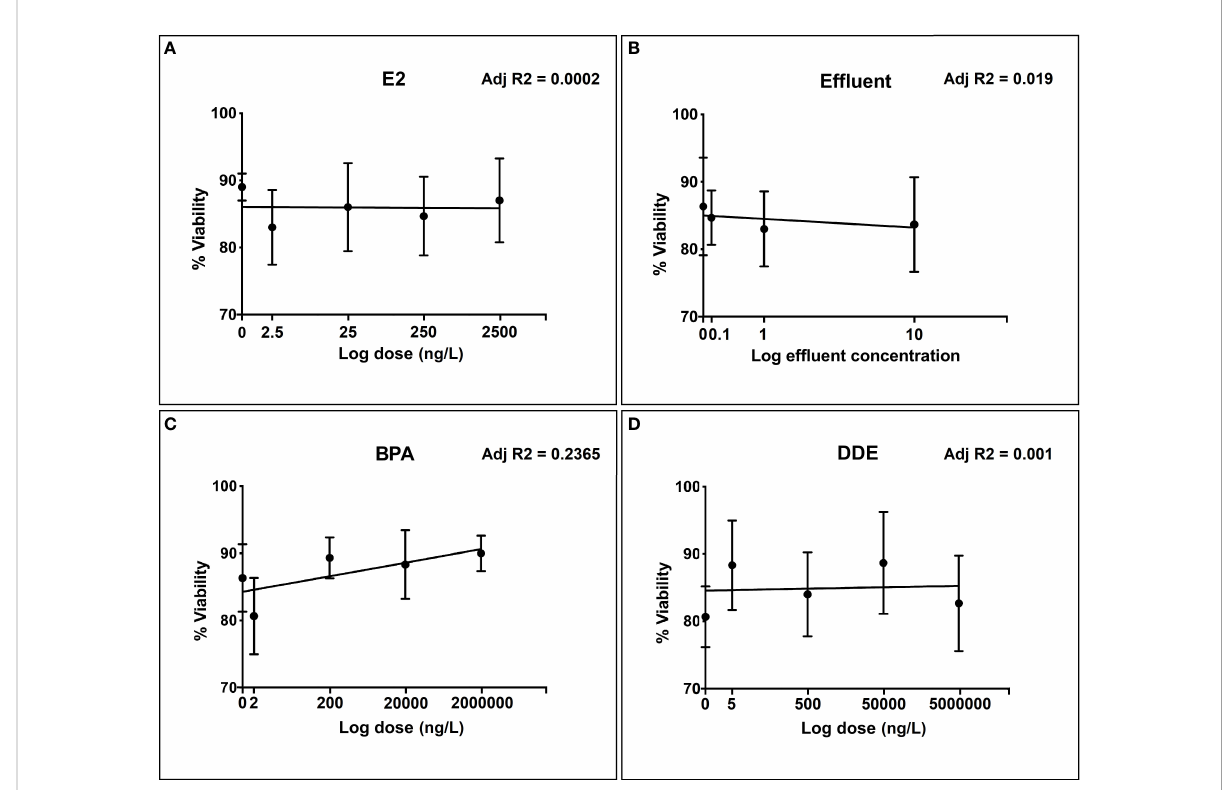
FIGURE 1 Toxicity evaluation of different doses of selected chemicals to snail hemocytes over the selected dose range for each test chemical. (A) 17 b -estradiol (E2); (B) Ef fl uent extract; (C) Bisphenol-A (BPA); (D) p ’ p-Dichlorodiphenyldichloroethylene (p,p ’ -DDE). Hemocyte viability measured as % of viable cells (± SEM of three independent replicates) according to Trypan blue